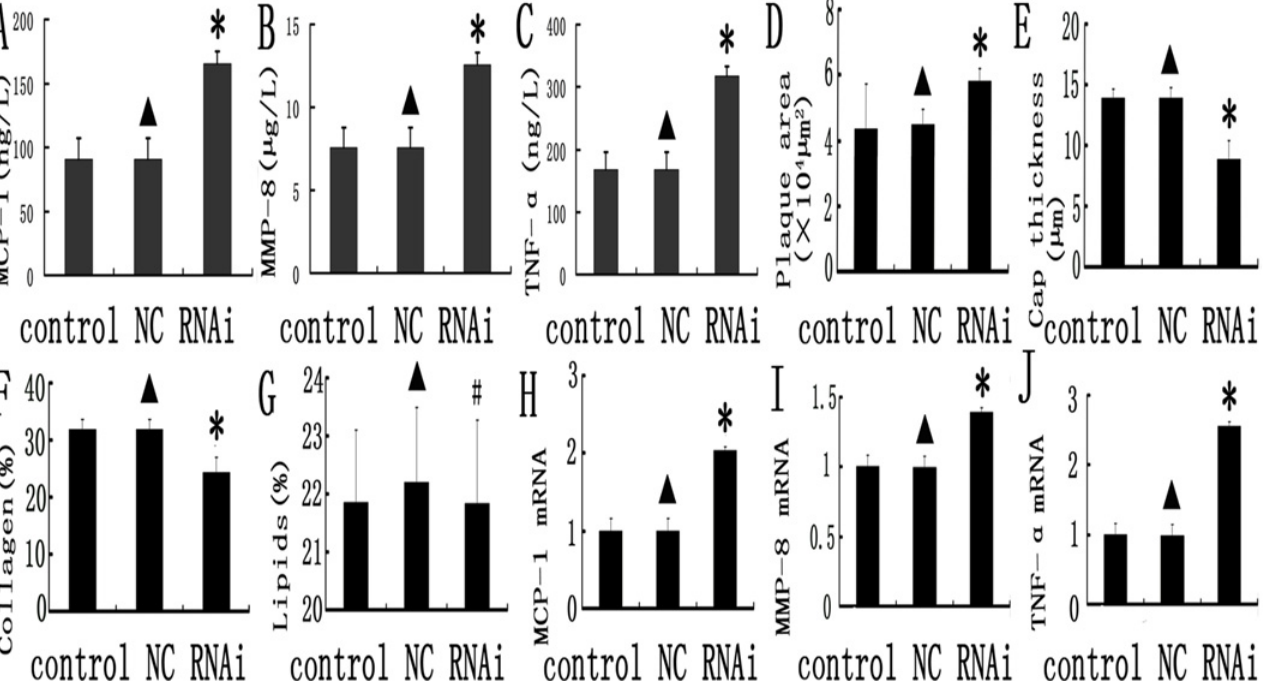
Fig 4. Inflammation gene expression and comparison of relative composition of plaques in the control, NC and MEF 2A RNAi groups. A, B, and C: inflammatory markers (MCP-1, MMP-8 and TNF- α ) in the control, NC, and MEF 2A shRNA groups; D, E,F and G plaque morphology in the control, NC, and MEF 2A shRNA groups; Plaque area (D), Fibirious cap thickness (E),collage content (F) and lipid content (G) were shown for the control, NC and RNAi groups. H, I and J: MCP-1 (H), MMP-8 (I) and TNF- α (J) mRNA expression in carotid plaques of the control, NC and shRNA groups at week 10 was detected by real-time PCR. Data were expressed as the mean ± SD. * P <